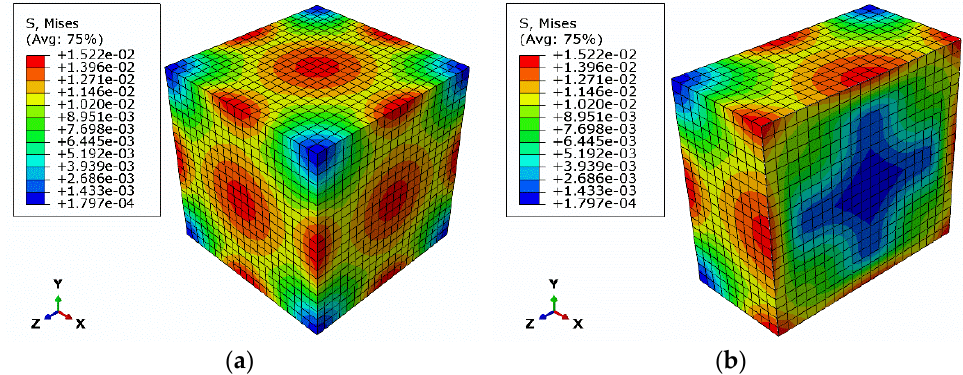
Figure 9. Thermal stress cloud in the last freeze – thaw cycle: ( a ) outer surface of the model; ( b ) profile of the model.